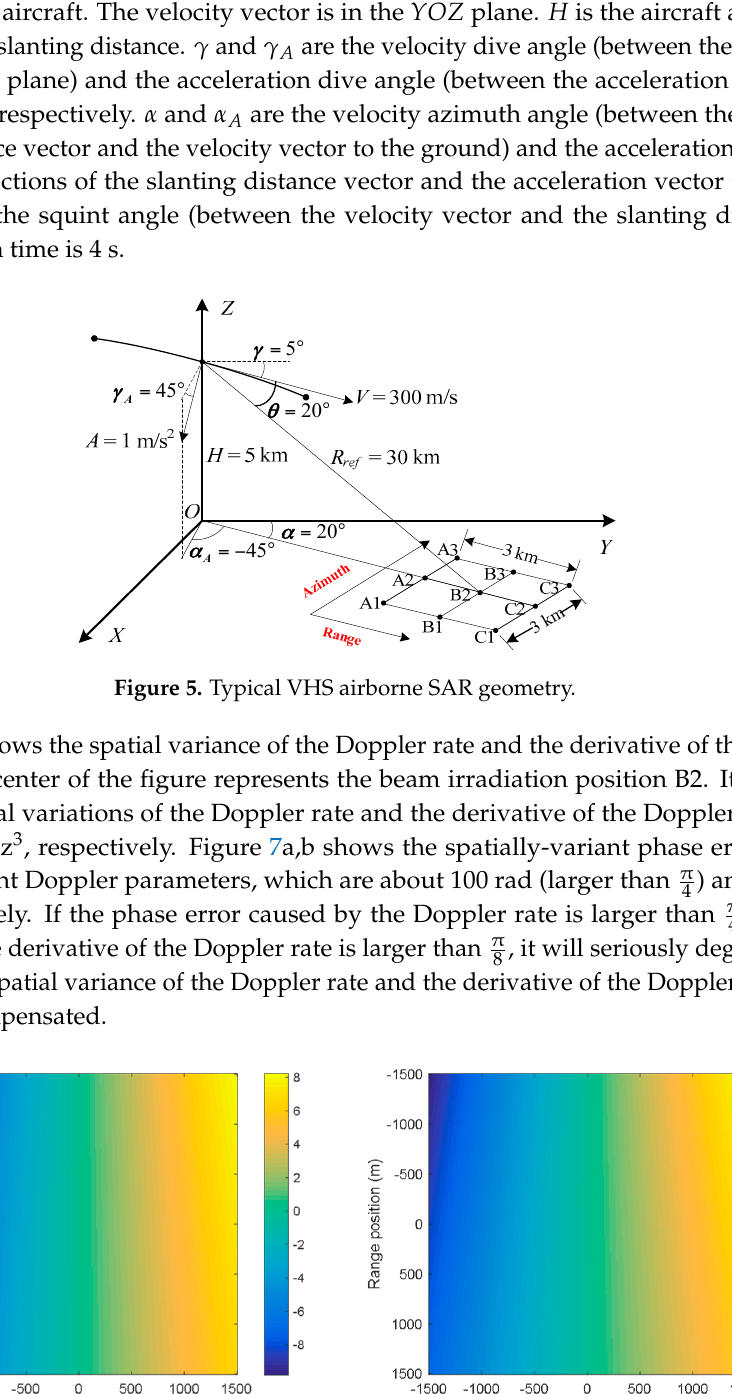
Figure 4. The flowchart of the azimuth compression combined with the EMAM method in the high- squint airborne SAR imaging algorithm.